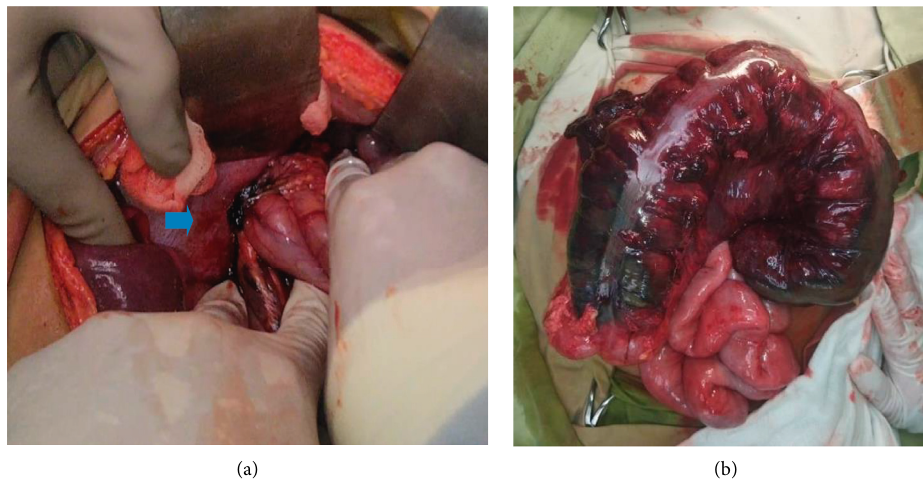
Figure 3: (a) The 8cm defect in the posterolateral left diaphragm (indicated by the arrow), through which the colon transversum, spleen, and half of the stomach had herniated. (b) The colon transversum was completely